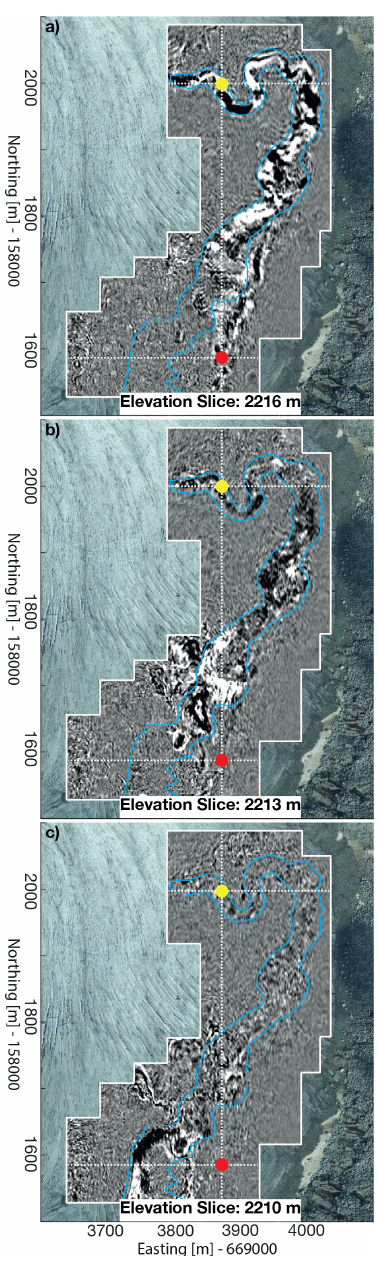
Figure 3. (a) Depth slice through the GPR 3D data cube at 2216ma.s.l., (b) 2213ma.s.l., and (c) 2210ma.s.l. The blue line represents the outline of the drainage network. The dashed white line represents the GPR profiles from Fig. 2 and the red and yel- low dots represent their crossing points. Orthophoto was provided by Swiss Federal Office of Topology. Reproduced by permission of swisstopo (JA100120), © 2020 swisstopo